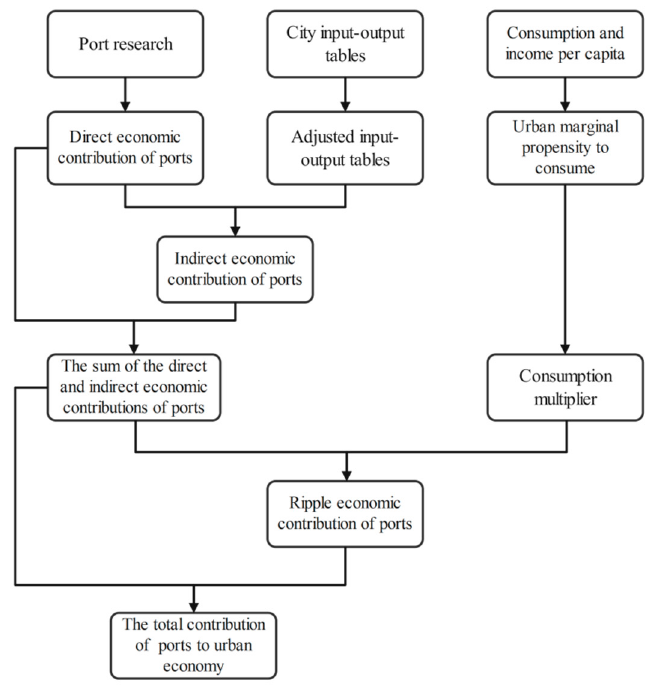
Figure 1. Technical roadmap for measuring the economic contribution of a port to a city.